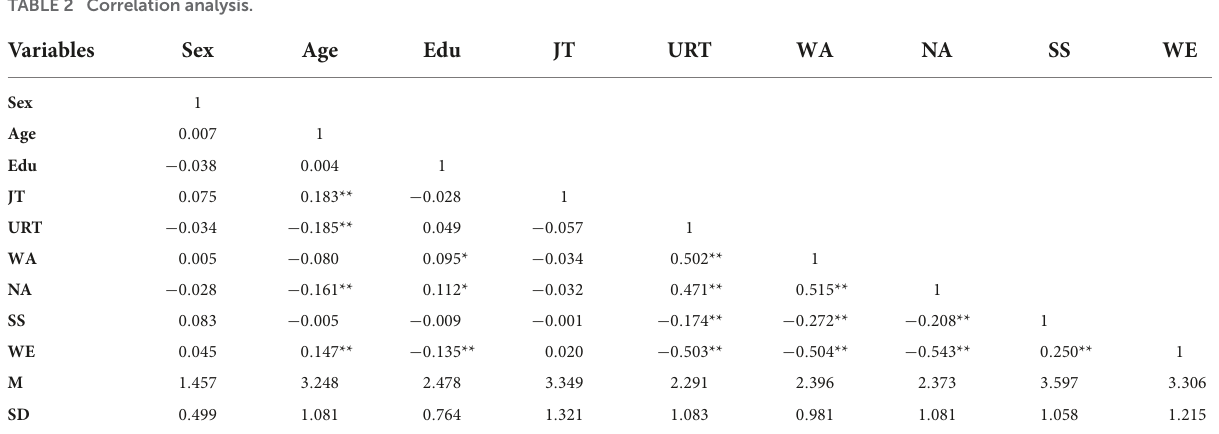
TABLE 2 Correlation